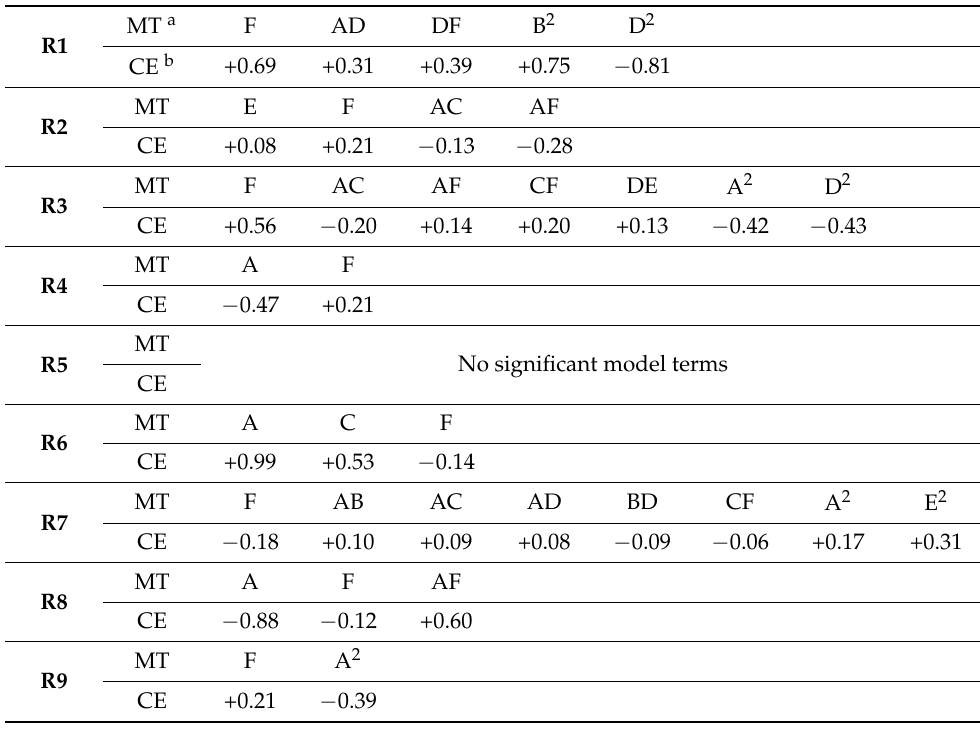
Table 5. Contingent combinations of the SPME conditions and final equation in terms of coded